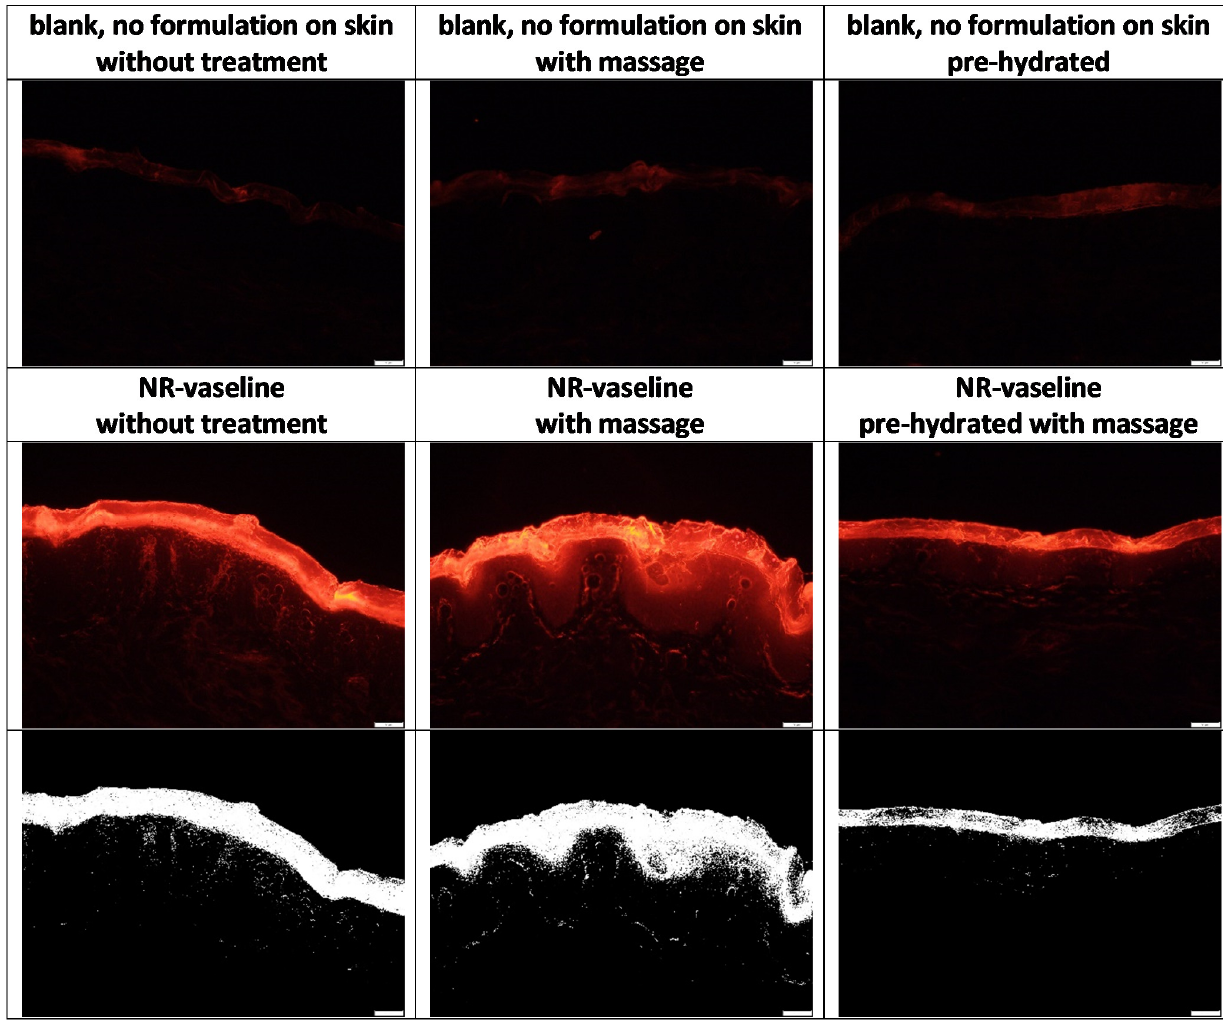
Figure 5. Images obtained from epifluorescence microscopy of the skin sections without Vaseline treatment (blank) and of the skin sections treated with Vaseline loaded with Nile red (middle row—original images, lower row—images after automated RGB Threshold). Scale bare = 50 µ